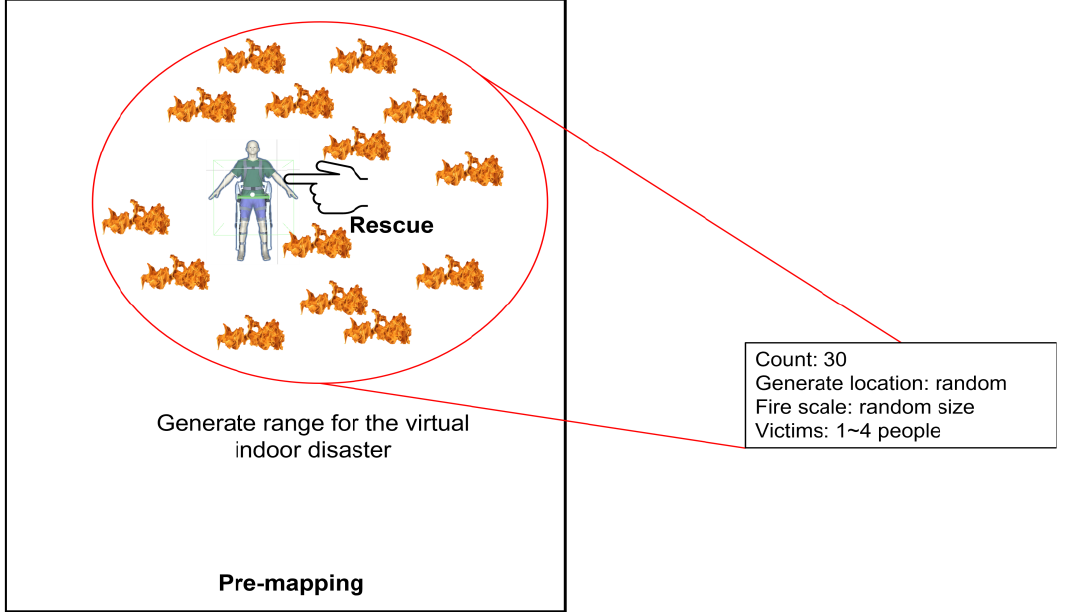
Figure 9. Schematic of the indoor virtual disaster.